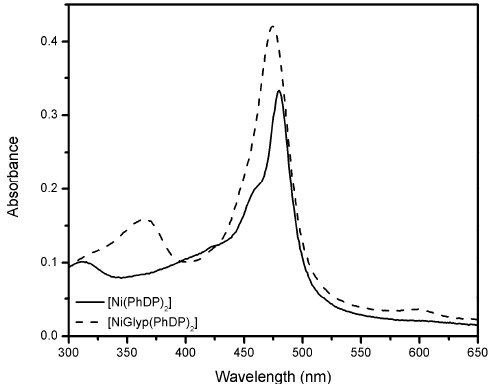
Figure 2. The electronic absorption spectrum of (Ni(PhDP) 2 ) (1.08 × 10 − 4 mol / L) in the absence (solid line) and the presence of glyp (1.1 × 10 − 5 mol / L) (dotted line). Reaction conditions: 99% CH 3 OH–1% water.